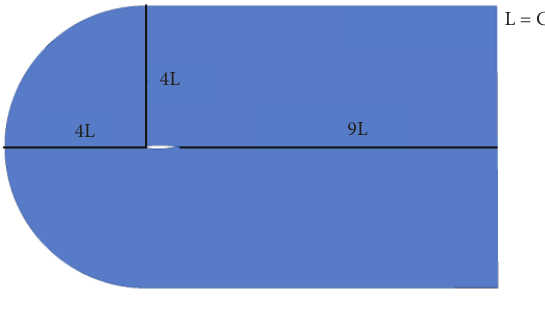
Figure 8. Computational domain.